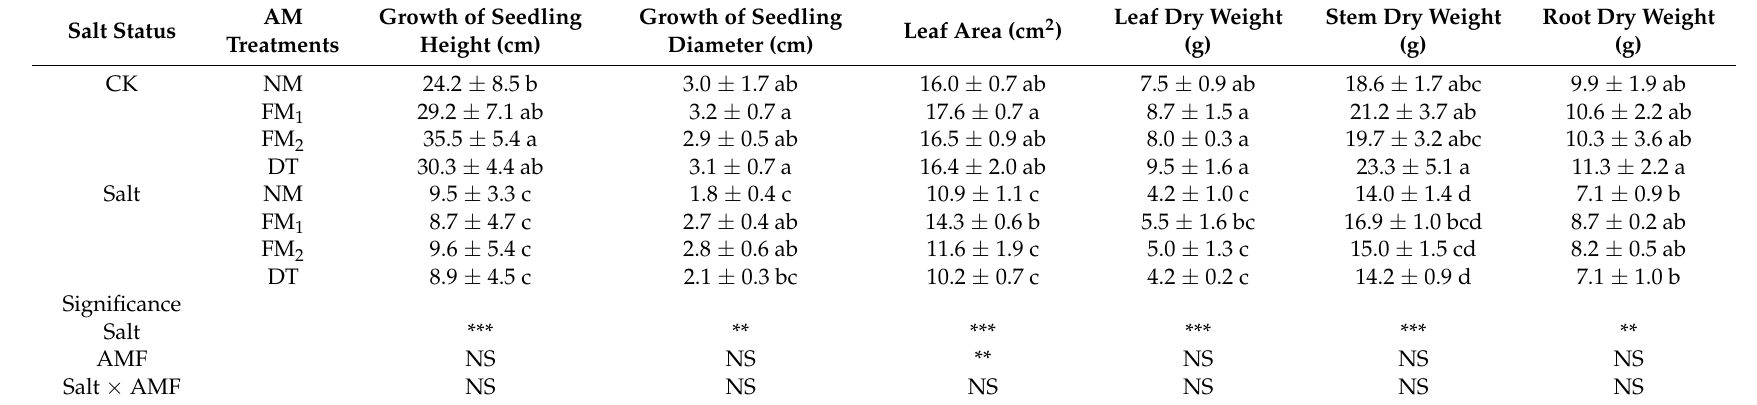
Table 1. Effects of three AMF strains on the growth of Z. serrata